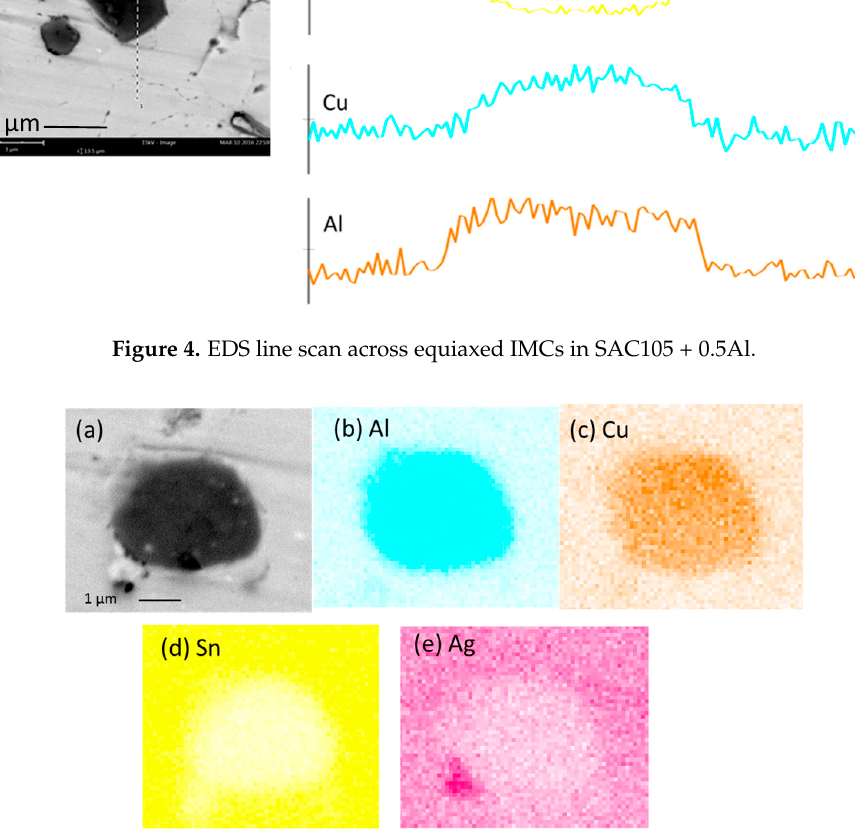
Figure 5. ( a ) Cross-sectioned image of SAC105 + 0.5Al after 1 × reflow. Elemental maps for the constituent elements: ( b ) Al; ( c ) Cu; ( d ) Sn; and ( e ) Ag.